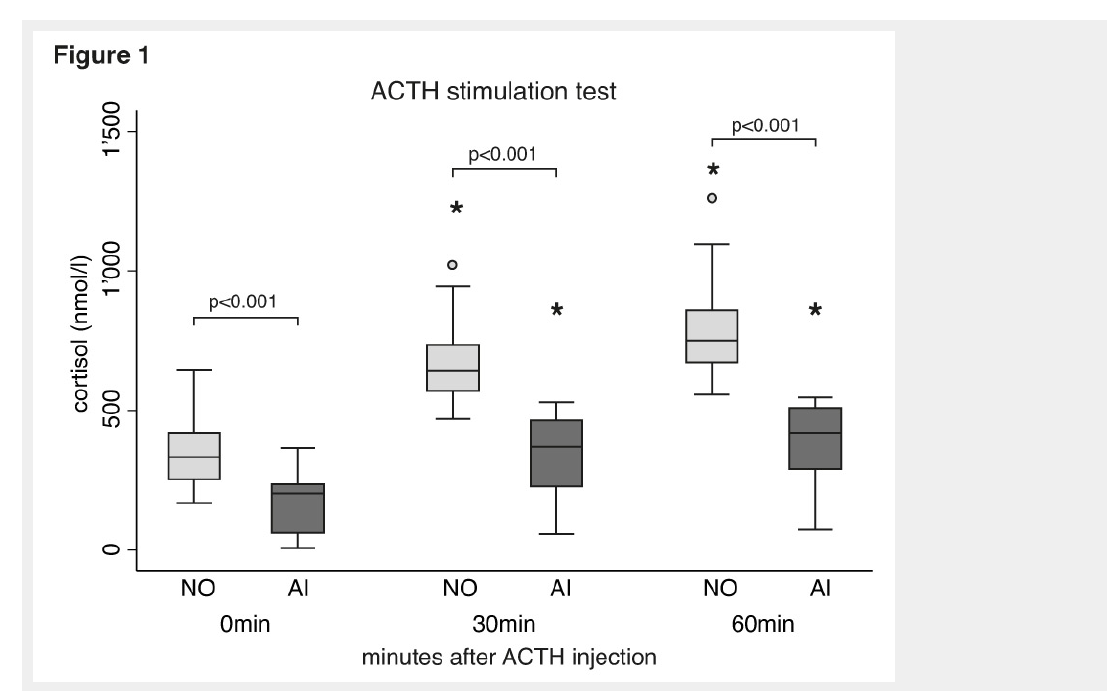
Figure 1 Cortisol values immediately before (0 min = baseline) and 30 minutes (30 min) and 60 minutes (60 min) after ACTH injection. Patients with adrenal insufficiency (AI) are plotted in dark grey; patients with normal adrenal function (NO) are plotted in light grey. * p <0.001 for comparison with baseline